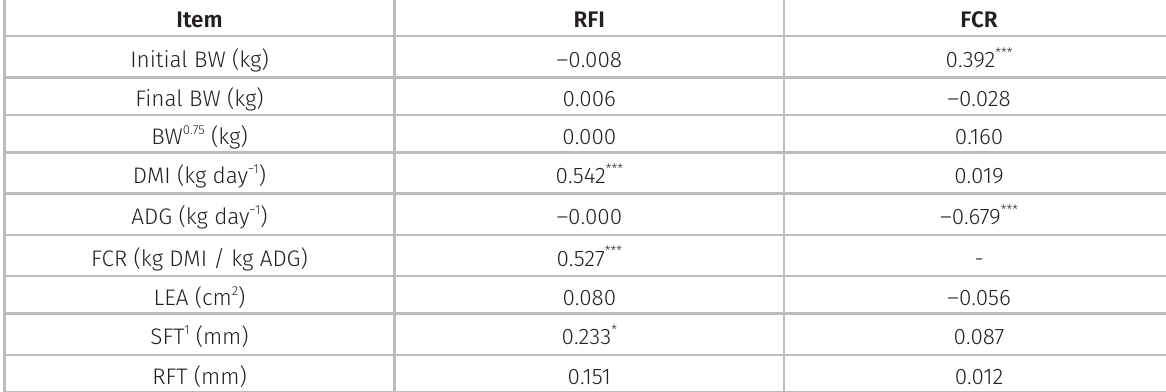
Table III. Correlation coefficients of growth performance, loin-eye area (LEA), subcutaneous fat thickness (SFT), and rump fat thickness (RFT) with residual feed intake (RFI) and feed conversion rate (FCR) of Nellore bulls.